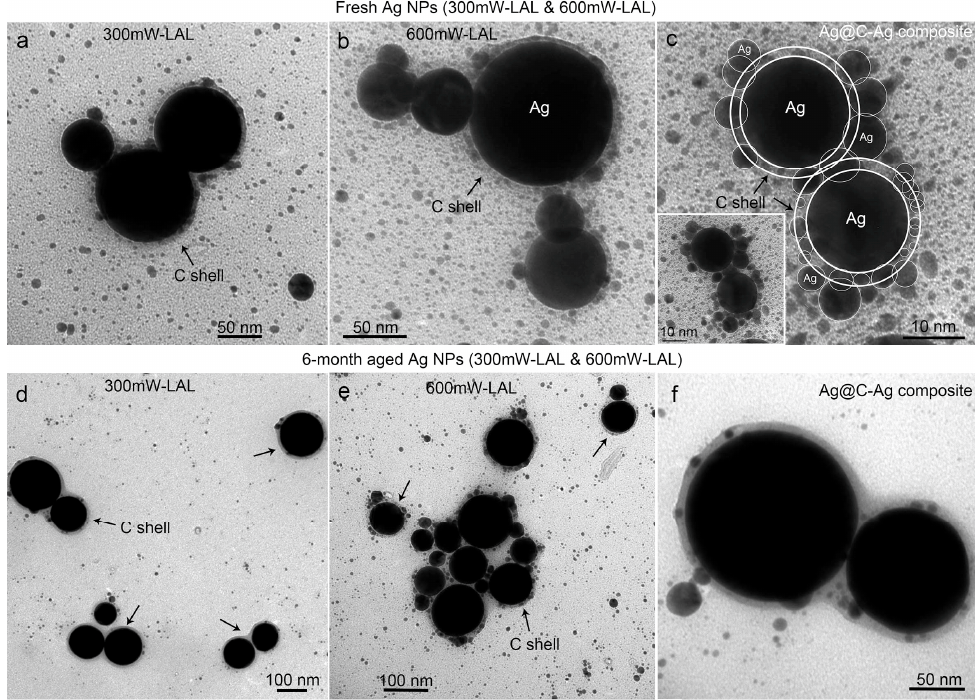
Figure 4. TEM images of the Ag@C core-shell particles observed in ( a – c ) fresh and ( d – f ) six month aged colloids synthesized by laser ablation in liquids (LAL), at laser powers of 300 mW ( a , d ) and 600 mW ( b , e ). The TEM images in ( c , f ) show the Ag@C-Ag composites from the fresh and the six month aged colloids.